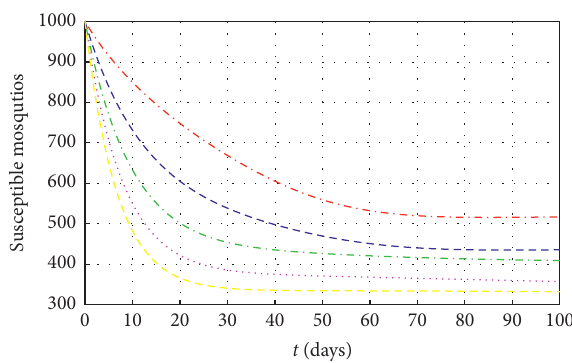
Figure 6: Population of susceptible mosquitoes with and without awareness (without awareness (red line); with low to high awareness rate awareness (blue, green, magenta, and yellow line)).